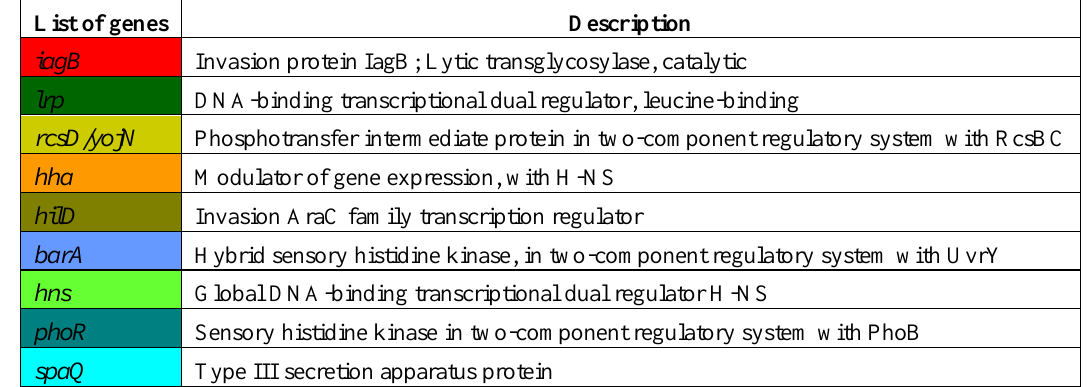
Table 6: Description for the genes in Figure 11b. The colour of gene corresponds to the colour of the line in the gene expression graph in